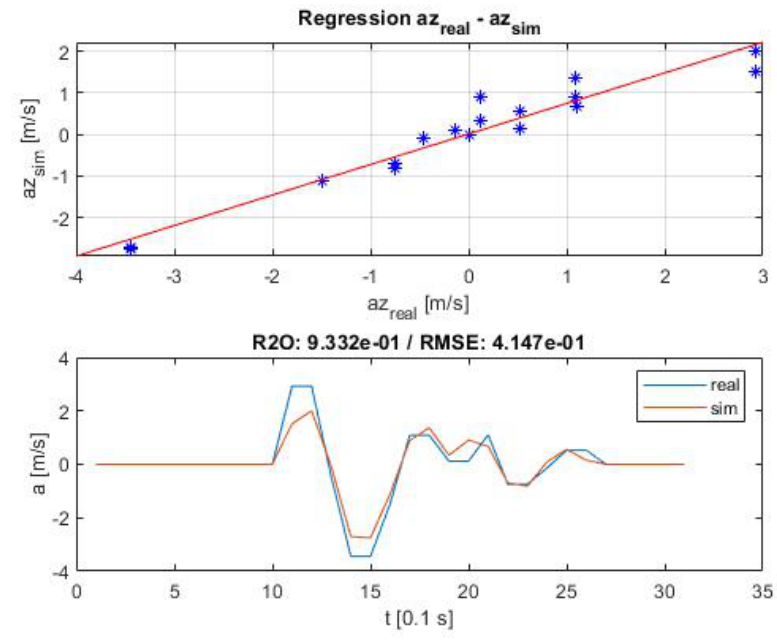
Figure A5. Validation of the z -acceleration in scenario 5 including ordinary R 2 and RMSE .